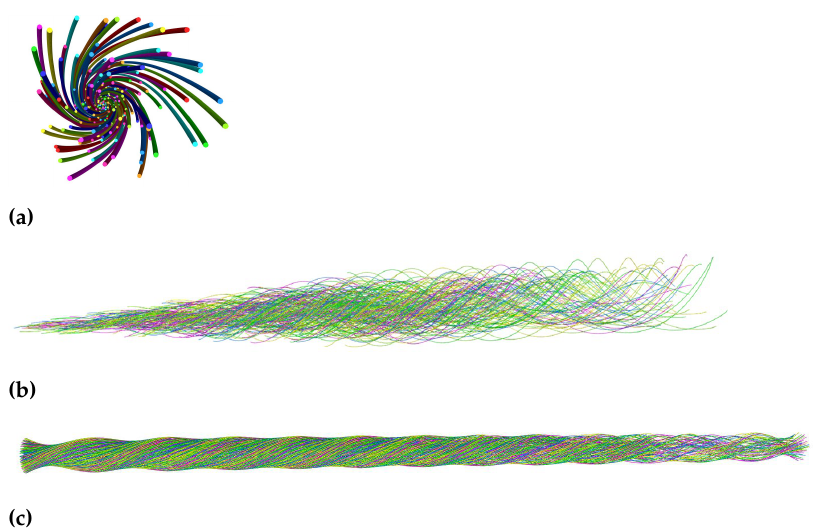
Figure 19. Staple yarn model (Random distribution of short fibre ( a ), staple yarn with small amount of twist ( b ), and with higher amount of twist ( c )).